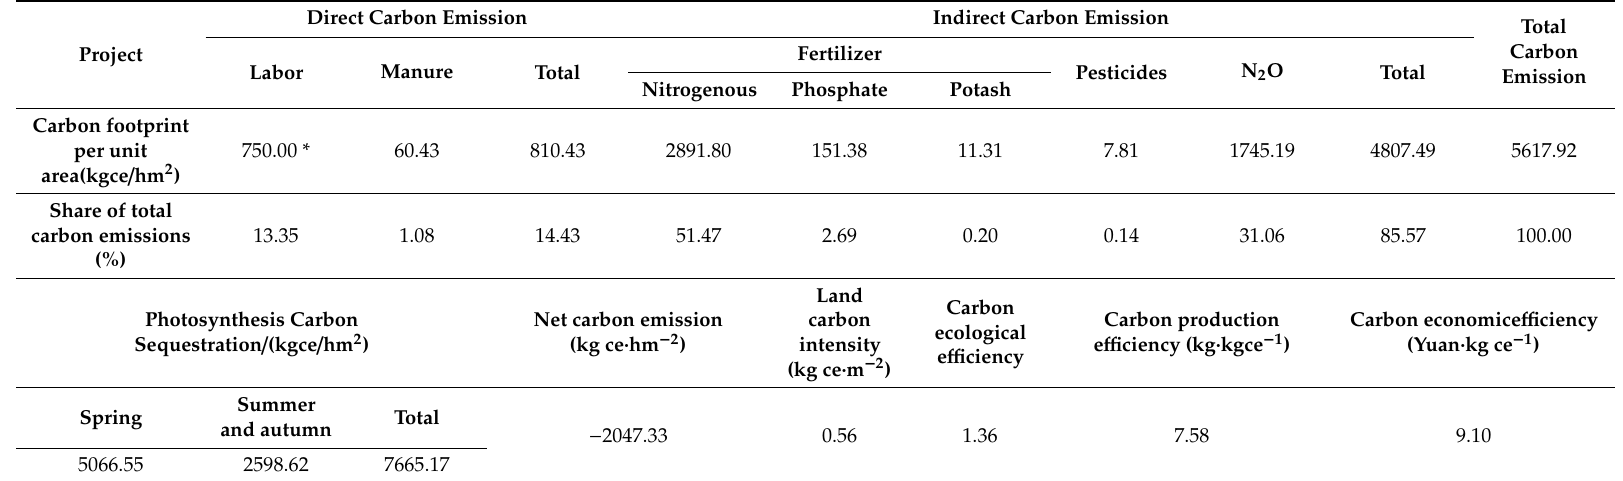
Table 2. Carbon footprint of mulberry planting stage in